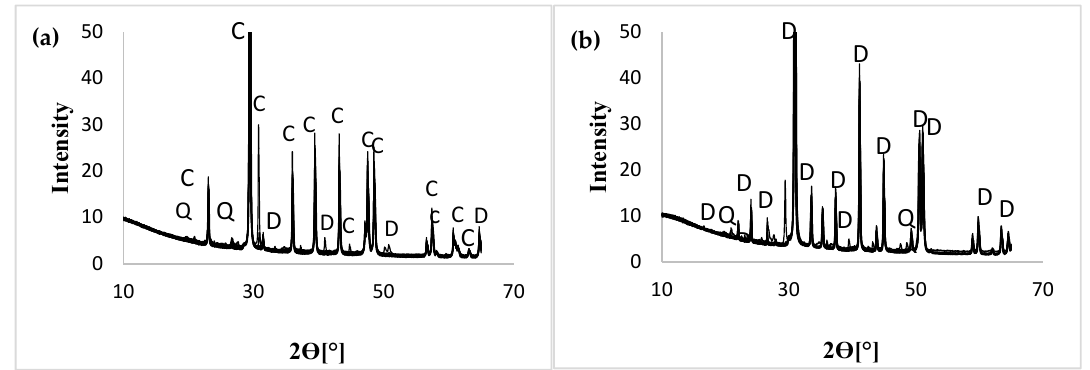
Figure 5. X-ray diffractograms. Different peak positions and heights display changes in mineralogical composition. ( a ) Calcite (C) rock samples ( n = 11); ( b ) Dolomite (D) rock samples ( n = 9).